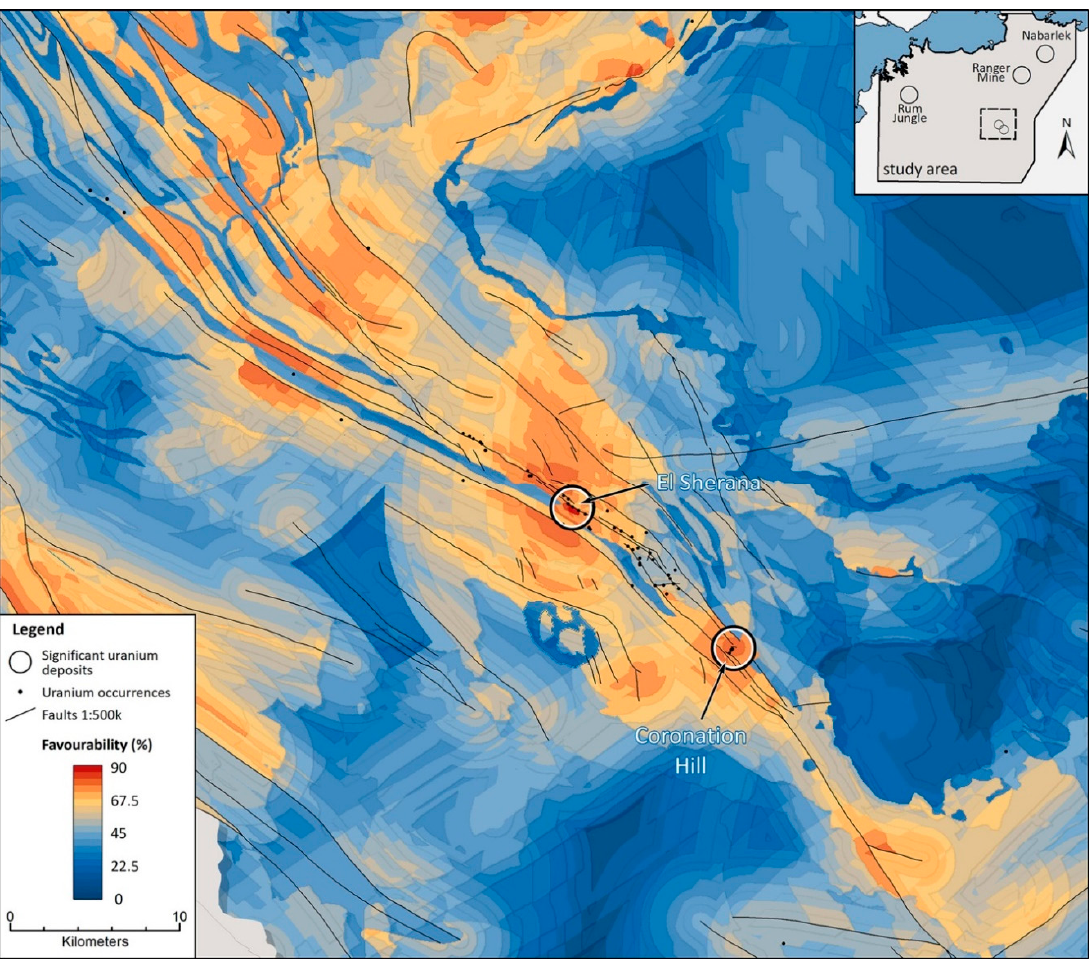
Figure 14. South Alligator Rivers Uranium Field MPM result. Note that the colour scale has been recalibrated relative to the previous figures.